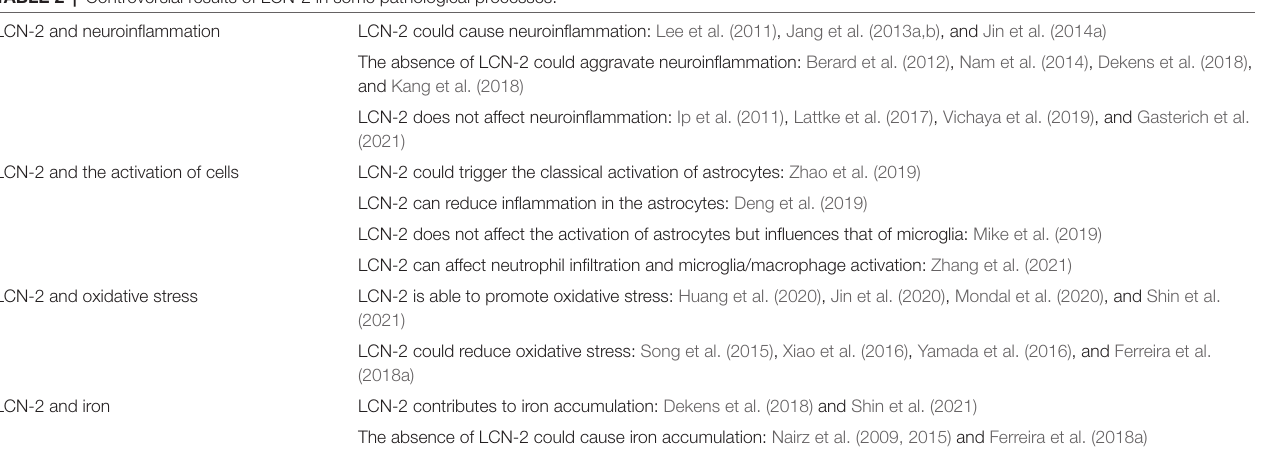
TABLE 2 | Controversial results of LCN-2 in some pathological